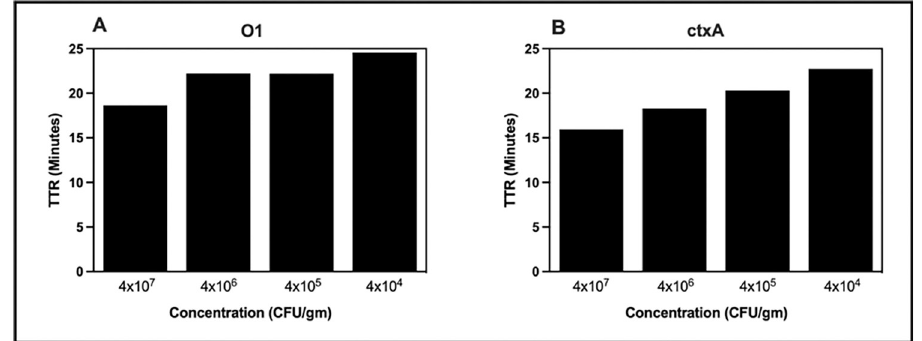
Fig 3. Lowest detection limit (LOD) of cholera RLDT tested directly from the stool. Stool samples were spiked with ten-fold serial dilutions of V . cholerae N16961. The spiked stool samples were processed and tested with the RLDT kit. LOD was determined as the lowest concentration at which the target gene was detected in all ten runs. A: O1 rfb gene; B: ctxA gene. https://doi.org/10.1371/journal.pntd.0011113.g003 stool. Reproducibility was tested using ten identically spiked stool samples with either 10 7 CFU or 10 5 CFU of cholera strain/gm of stool over three days. We observed positive results for all (100%) of the repeatability and reproducibility assays that were tested. During the repeat- ability and reproducibility experiments, we determined the % CV of the TTR values of the ctxA and O1 rfb genes which ranged from 4.6% to 6.3% for ctxA and 8% to 13.4% for O1 rfb (Table 3). To understand if cholera RLDT could be used as a semi-quantitative assay, we